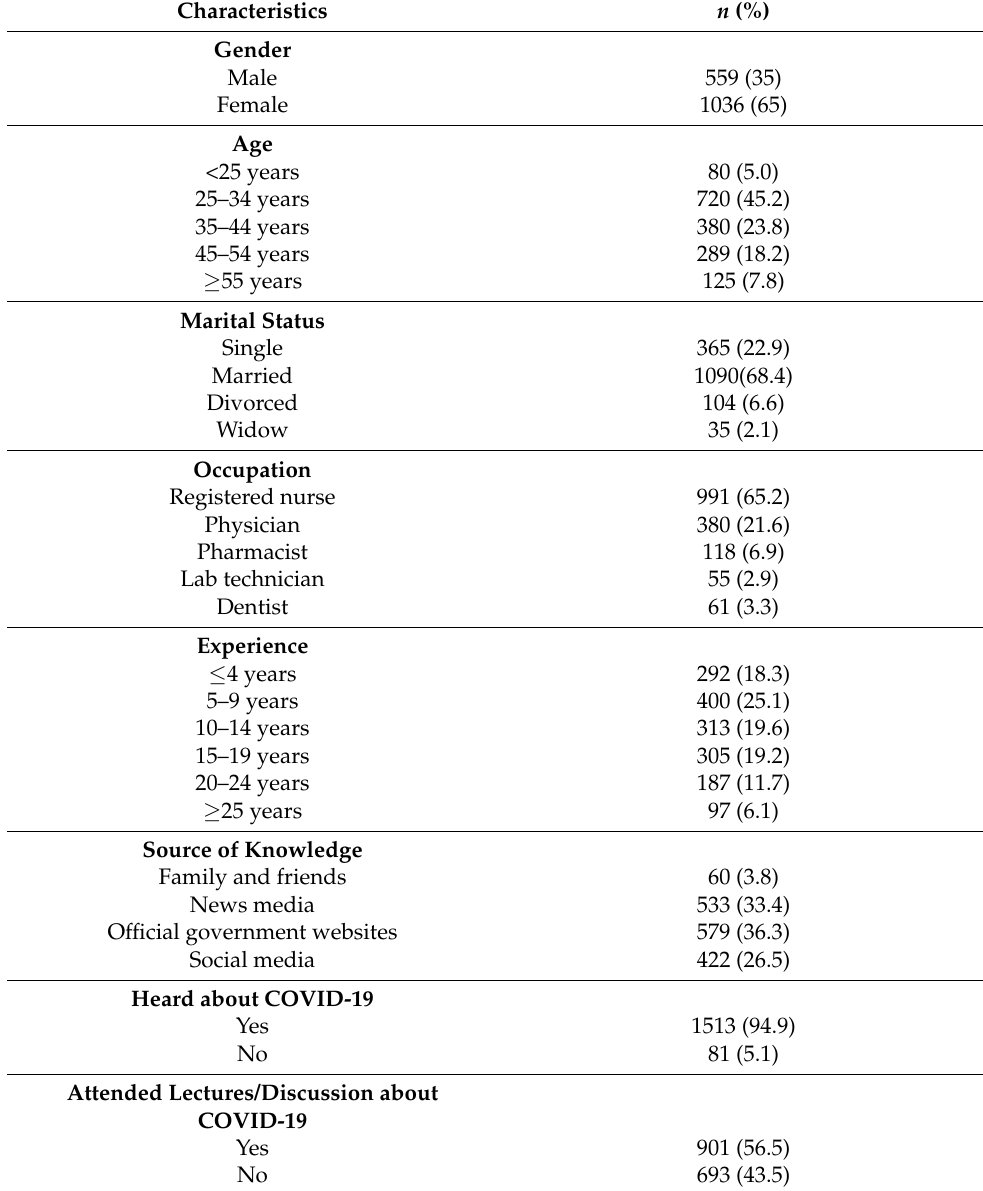
Table 1. Sociodemographic characteristics of healthcare workers ( n =